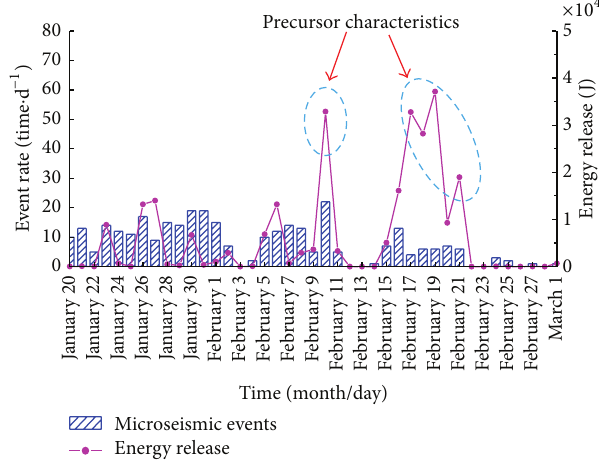
Figure 8: Correlation chart between energy release of microseismic events and activity rate and time (January 20 to March 1,